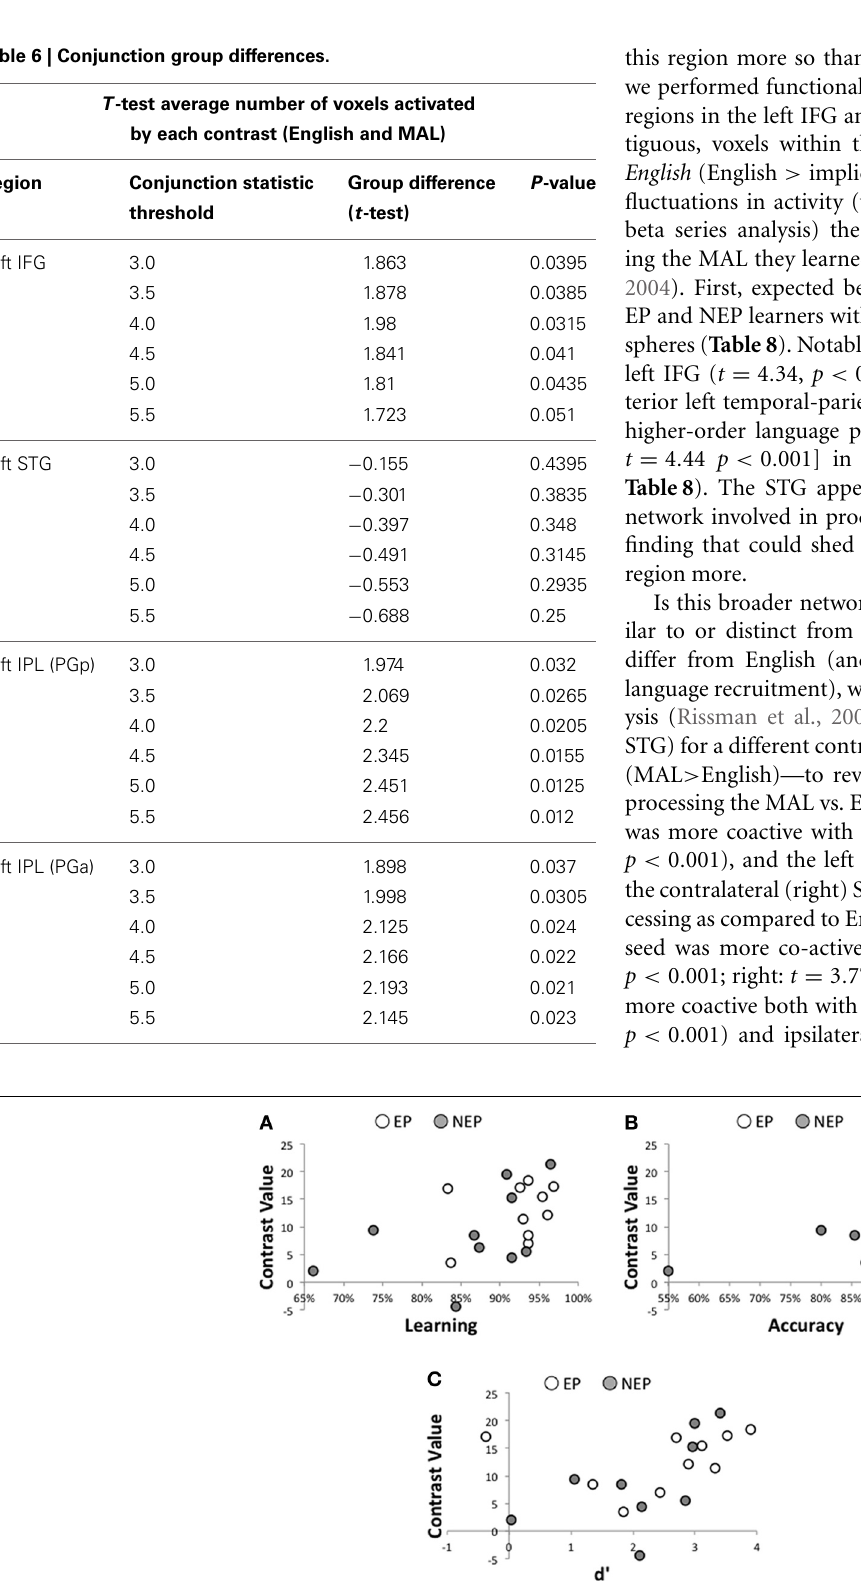
Frontiers in Systems